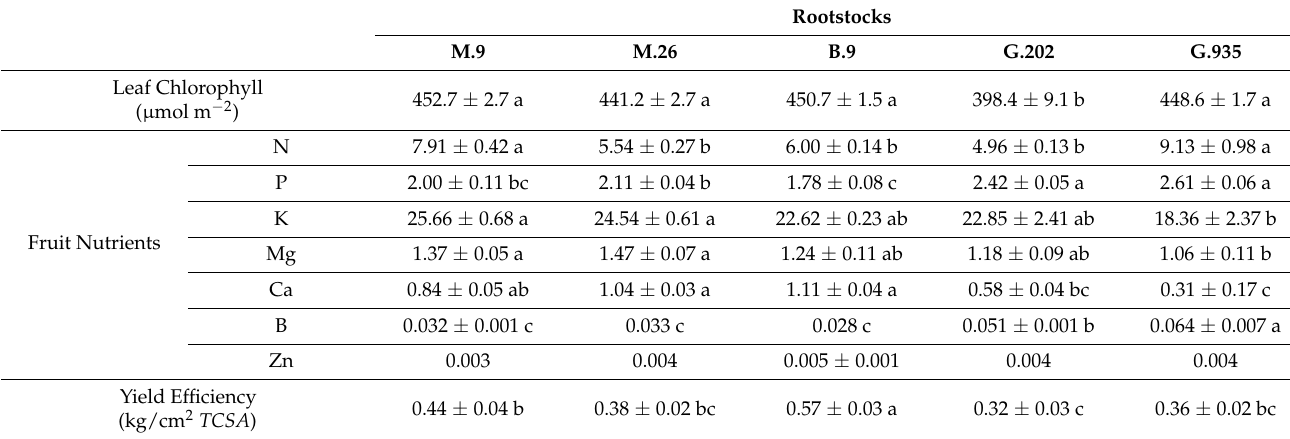
Table 2. Leaf chlorophyll concentration, fruit mineral nutrient levels and yield efficiency of Ambrosia TM scions on five rootstocks in the second-year planting in